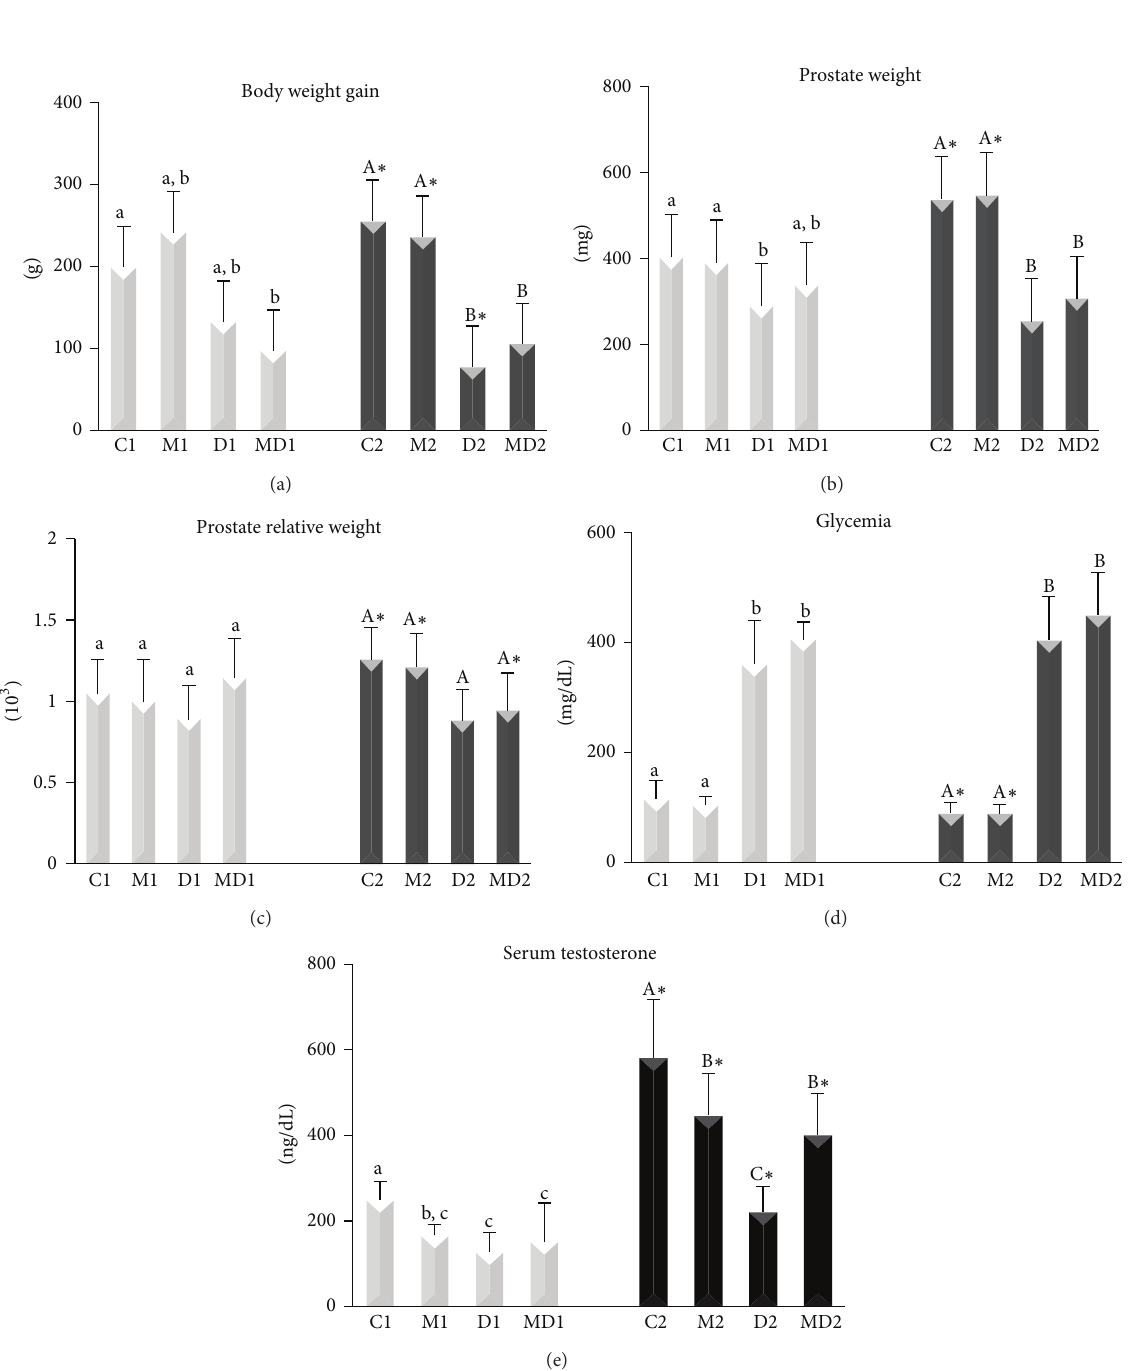
Figure 1: Mean and standard deviation of body weight gain (a), prostate wet weight (b), prostate relative weight (c), blood glucose levels (d), and serum testosterone (e). C1: short-term control; M1: short-term control treated with MLT; D1: short-term untreated diabetic; MD1: short-term diabetic treated with MLT; C2: long-term control; M2: long-term control treated with MLT; D2: long-term untreated diabetic; and MD2: long-term diabetic treated with MLT. Light bars: short-term experiment and dark bars: long-term experiment ( 𝑁 = 10 animals/group). Different lowercase letters indicate significant differences between experimental groups C1, M1, D1, and MD1 (parametric data: prostate weight, relative prostate weight, and serum testosterone; nonparametric data: body weight gain, glycemia), and different capital letters indicate significant differences between groups C2, M2, D2, and MD2 (parametric data: body weight gain, prostate weight, relative prostate weight, and serum testosterone; nonparametric data: glycemia). ∗ Significant difference between experimental periods ( t -test or Mann-Whitney U